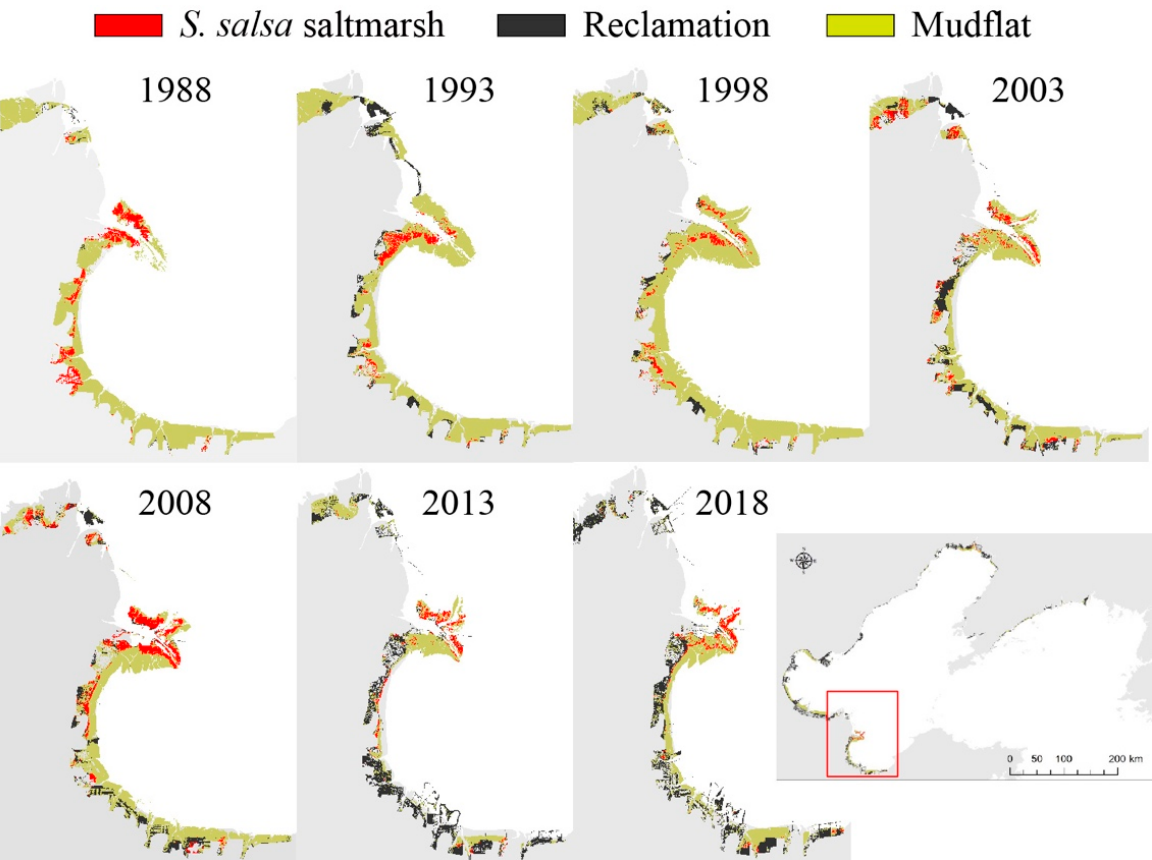
Figure 6. Maps showing the land cover change of S. salsa saltmarsh areas and mudflats and the reclaimed land in Yellow River Delta wetland and Guangli-Zhima estuarine wetland between 1988 and 2018.